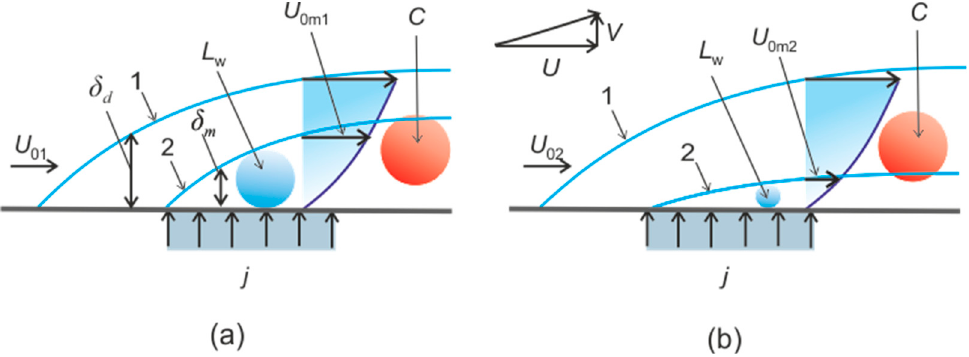
Figure 6. Characteristic boundary layers for velocity profile and diffusion profile ( U 01 < U 02 ).